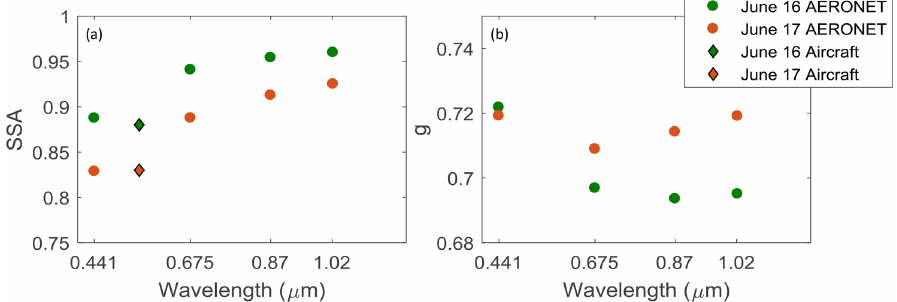
Figure 4. (a) AERONET/DS2 column-integrated (circles) and aircraft/DS3 averaged (diamonds) SSA values on 16 June at 16:22UTC and 17 June at 07:20UTC. (b) AERONET g values for the same periods. Table 5. Summary of the data used to obtain α aer (λ,z) , SSA( λ,z ), and g(λ,z) in the LW spectral range from Mie calculations, i.e., the refractive index, RI; effective radius, r eff ; geometric standard deviation, σ ; and number concentration, N . Three different datasets are used (DS1, DS2, and DS3) based on different particle size distribution (PSD) data used. The indications below the sources of the aerosol parameters indicate whether the parameter is column-integrated (col) or if it is vertically resolved ( z ) and the number of wavelengths at which it is given (nλ) . DB (2017) stands for Di Biagio et al. (2017). LW DS1 DS2 DS3 RI DB (2017), (col, 601 λ ) DB (2017), (col, 601 λ ) DB (2017), (col, 601 λ Mie calculations